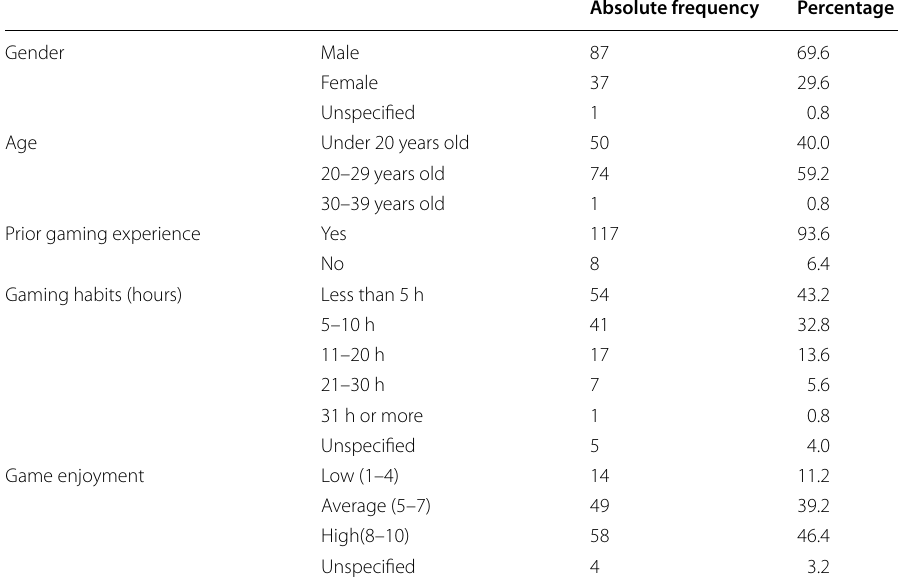
Table 1 Demographic data of participants, n